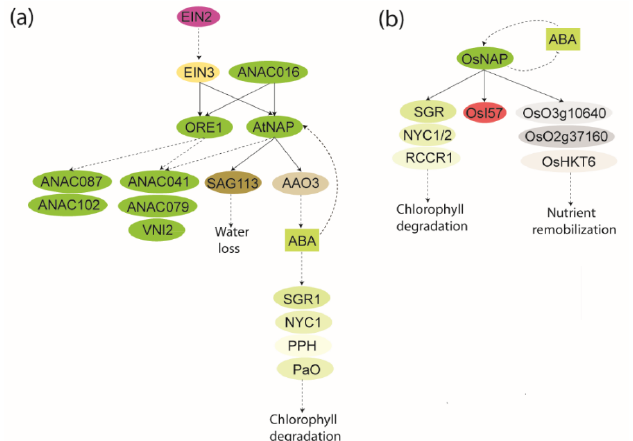
Figure 4. Schematic showing local GRN of senescence associated NAP. ( a ) GRN of At NAP. The AtNAP-SAG113 connection is derived from Zhang et al. [86], the EIN2- EIN3-ORE1/AtNAP/ANAC087/ANAC102/ANAC041/ANAC079/VNI2 connections are derived from Kim et al. [108], the ANAC016- At NAP connection is derived from Kim et al. [63], and the AtNAP-AAO3-ABA-SGR1/NYC1/PPH/PaO connection is derived from Yang et al. [87]. Thus, all components may not be part of the same functional GRN ( b ). GRN of Os NAP. Genes downstream of Os NAP are related to chlorophyll degradation and nutrient transport. The connections are derived from Liang et al. [28]. Direct binding is shown by black lines, whereas broken lines indicate an effect which may not necessarily involve a direct interaction. NAC genes/proteins are shown in green. The rest of the color coding is specific for specific compounds or